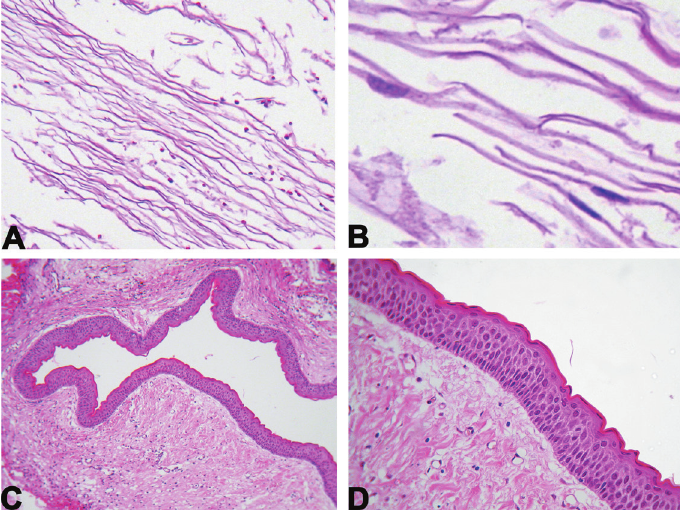
Figure 3- A, cytological analysis (cell block) of keratocystic odontogenic tumor showing keratin [hematoxylin-eosin (H&E)100x] and, B, parakeratin (high magnification) (H&E 1,000x); C, histopathological analysis of the same lesion with a conjunctive tissue capsule lined by thin and uniform epithelial tissue (H&E 100x); D, high magnification showing the stratified epithelial lining with a palisade basal layer and corrugated parakeratin on the surface (H&E